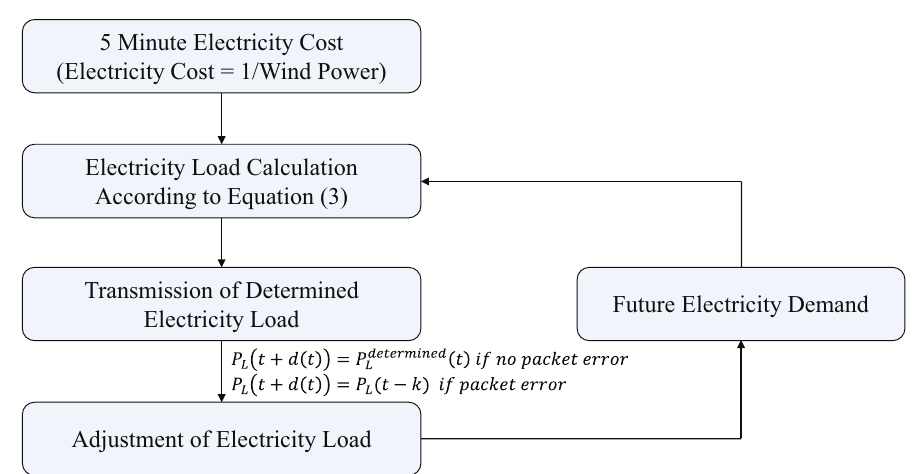
Figure 9. The operational flow of the application model.